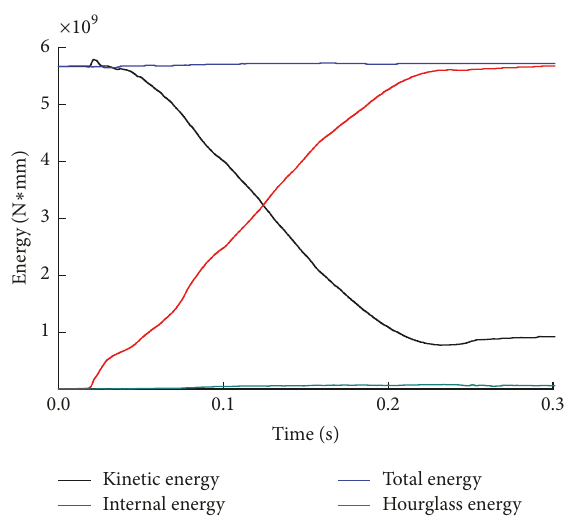
Figure 14: Development of various